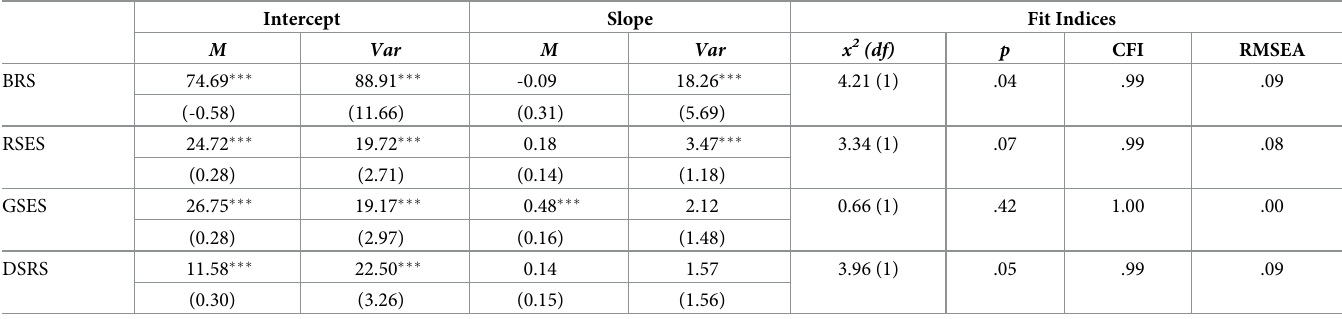
Table 3. Efficacy of the intervention in latent growth curve model